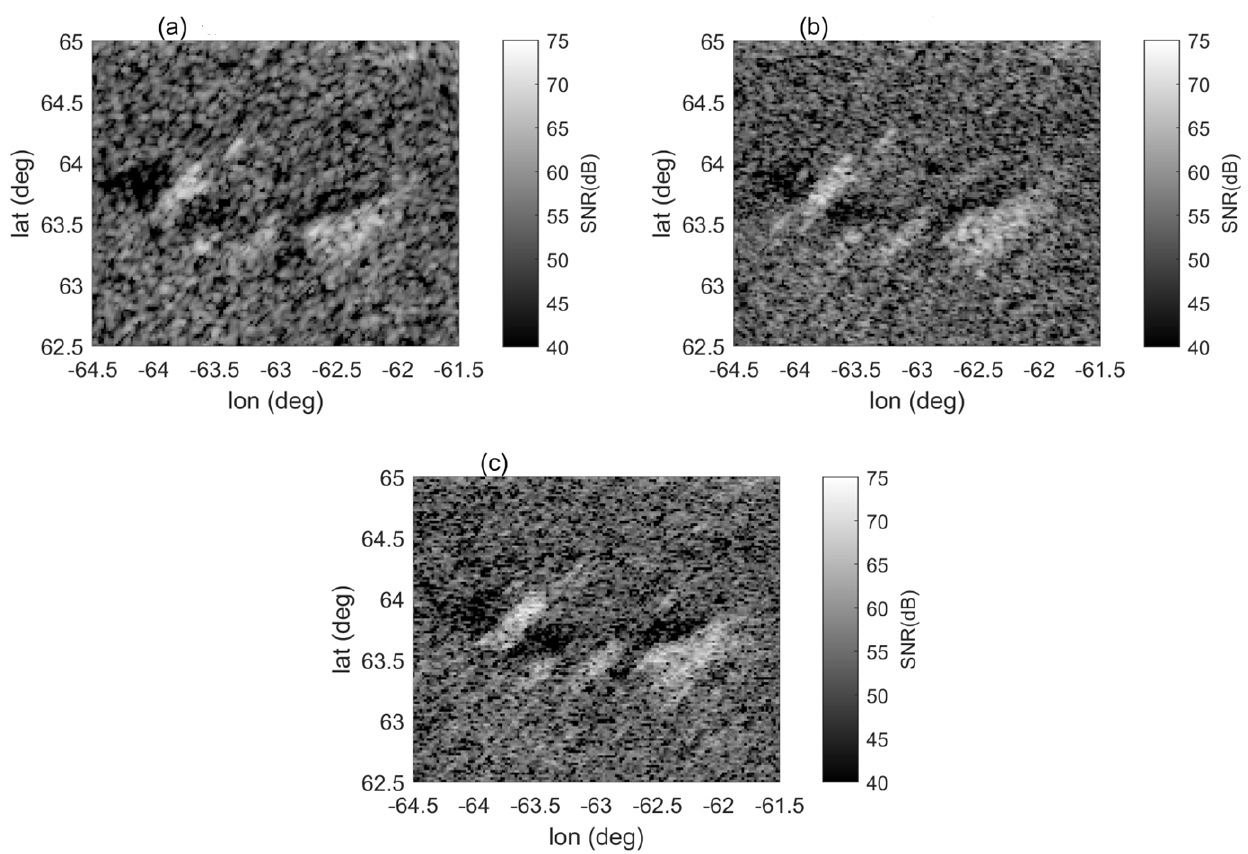
Figure 5. Imaging results of the magnified areas in Figure 4. The processing algorithms and coherent integration times applied here are consistent with those in Figure 4. ( a ) RD algorithm 4 min; ( b ) RD algorithm 8 min; ( c ) BP algorithm 8 min.